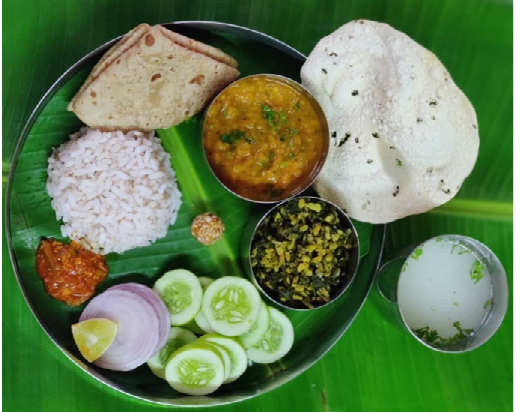
Figure 1. Typical Indian Thali. Thali consisting of whole wheat chapati , brown rice, lentil curry, green vegetable with split yellow lentil, cucumber slices, onion slices, lemon wedge, pickle, thin, spiced, roasted disc made of pulse (papad) , buttermilk with herbs, and a sweet ( sesame ladoo ), served on a banana leaf. This original picture is representative of a regular, homemade Indian Thali prepared by author S.S.